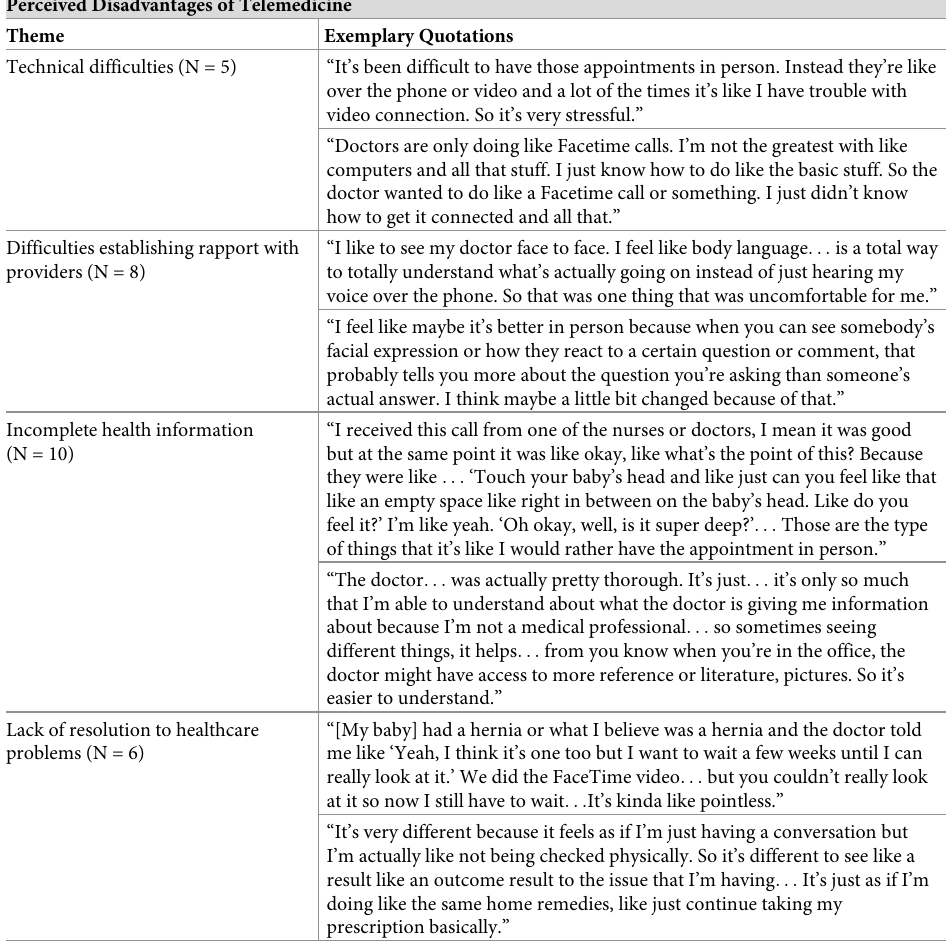
Table 5. Perceptions of participants on telemedical